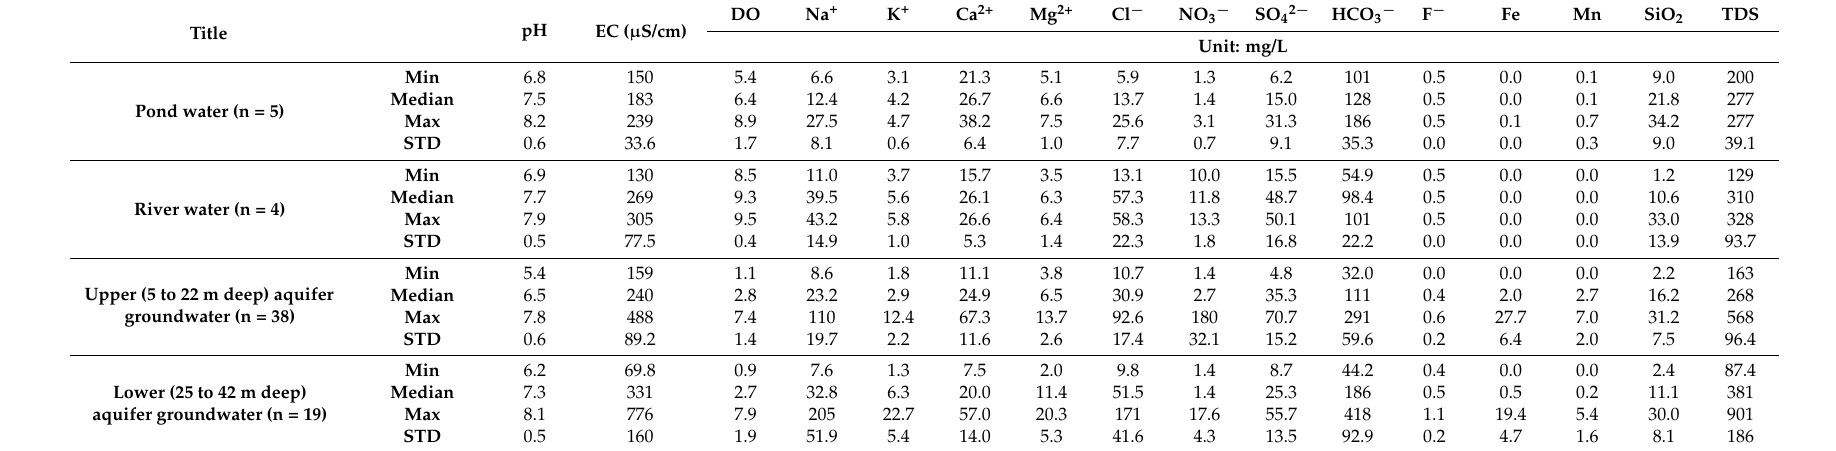
Table 1. Statistical summary of hydrochemical data of water samples from the study area.